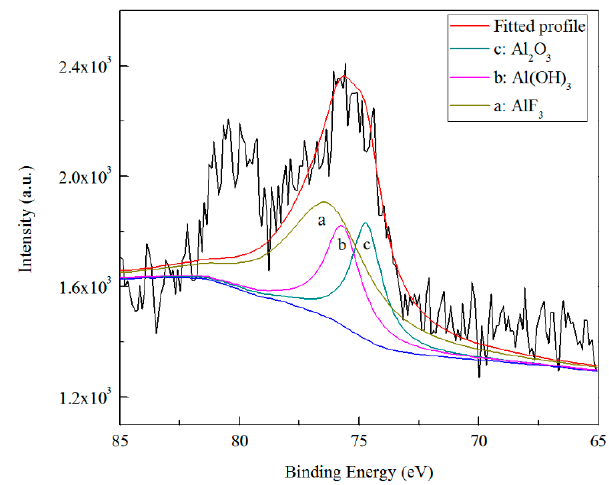
Figure 15. High resolution XPS spectrum and curve fitting for Al 2 p photoelectron region for a TCC formed on Zn55Al for 180 s in TCP bath at 40 ° C.